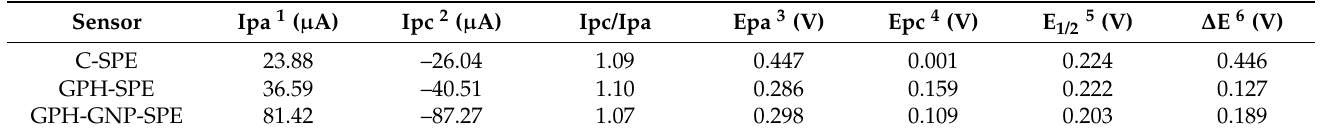
Table 1. The main features of electrodes obtained by cyclic voltammetry.